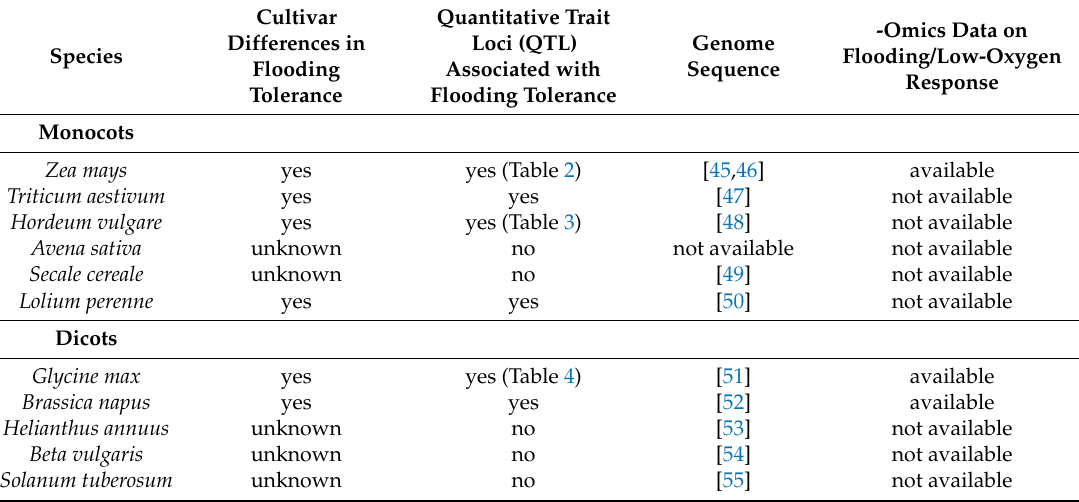
Table 1. Overview over crop species referred to in this review